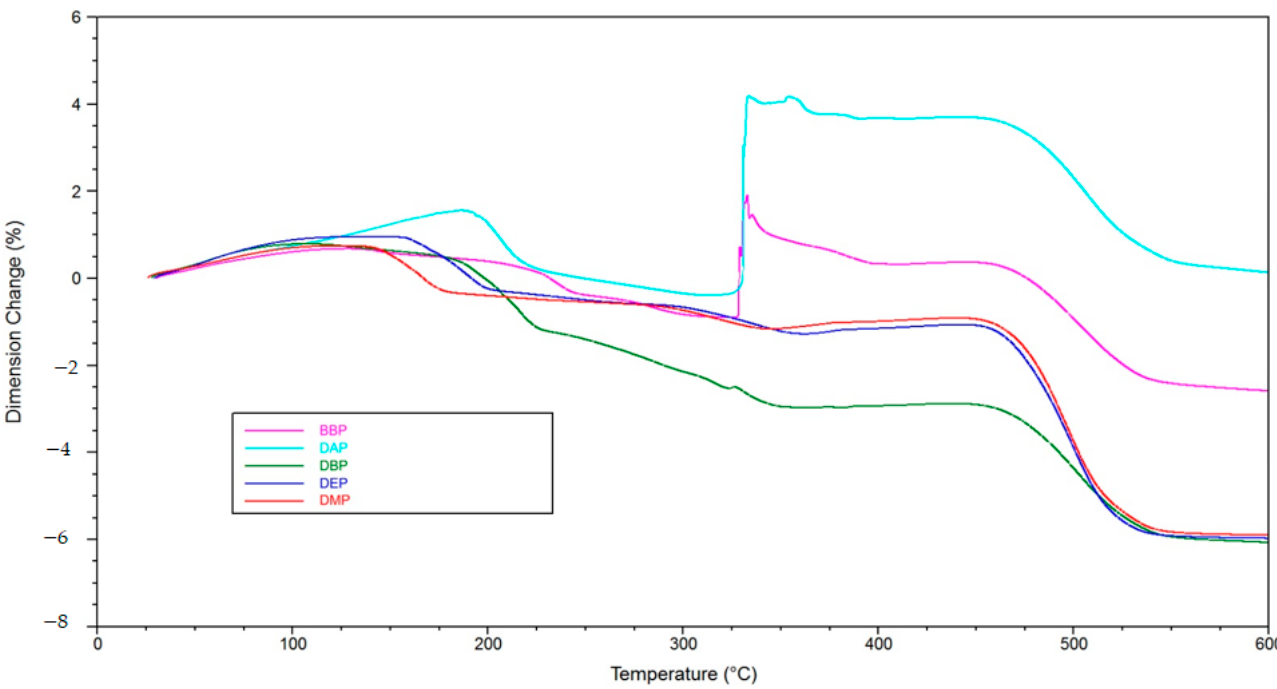
Figure 14. Detailed depiction of the thermomechanical analysis from Figure 13 .